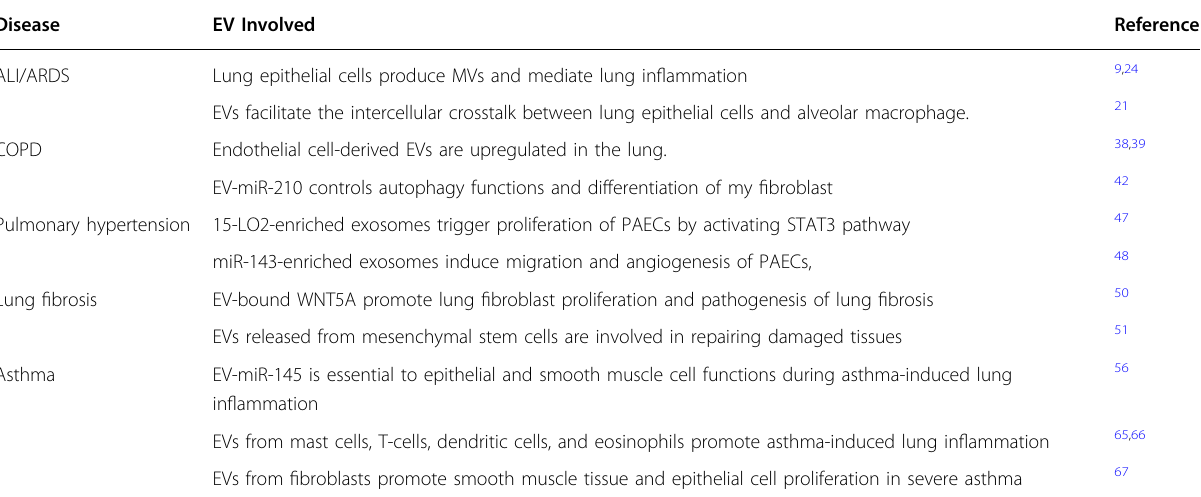
Table 1 List of respiratory diseases associated with EV functions. Disease EV